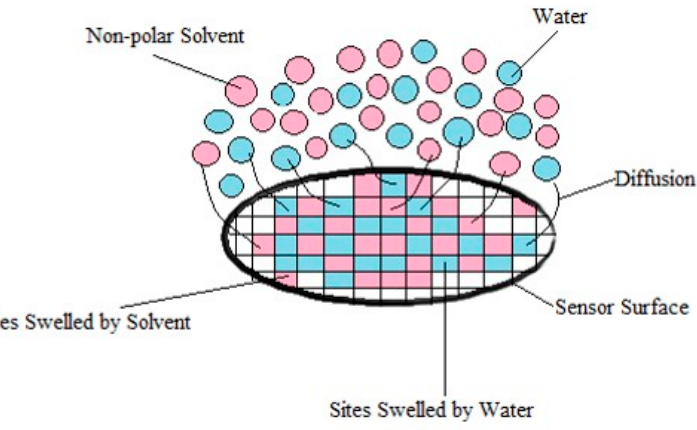
Figure 11. Assumed organisation of non-polar VOC with water molecules.